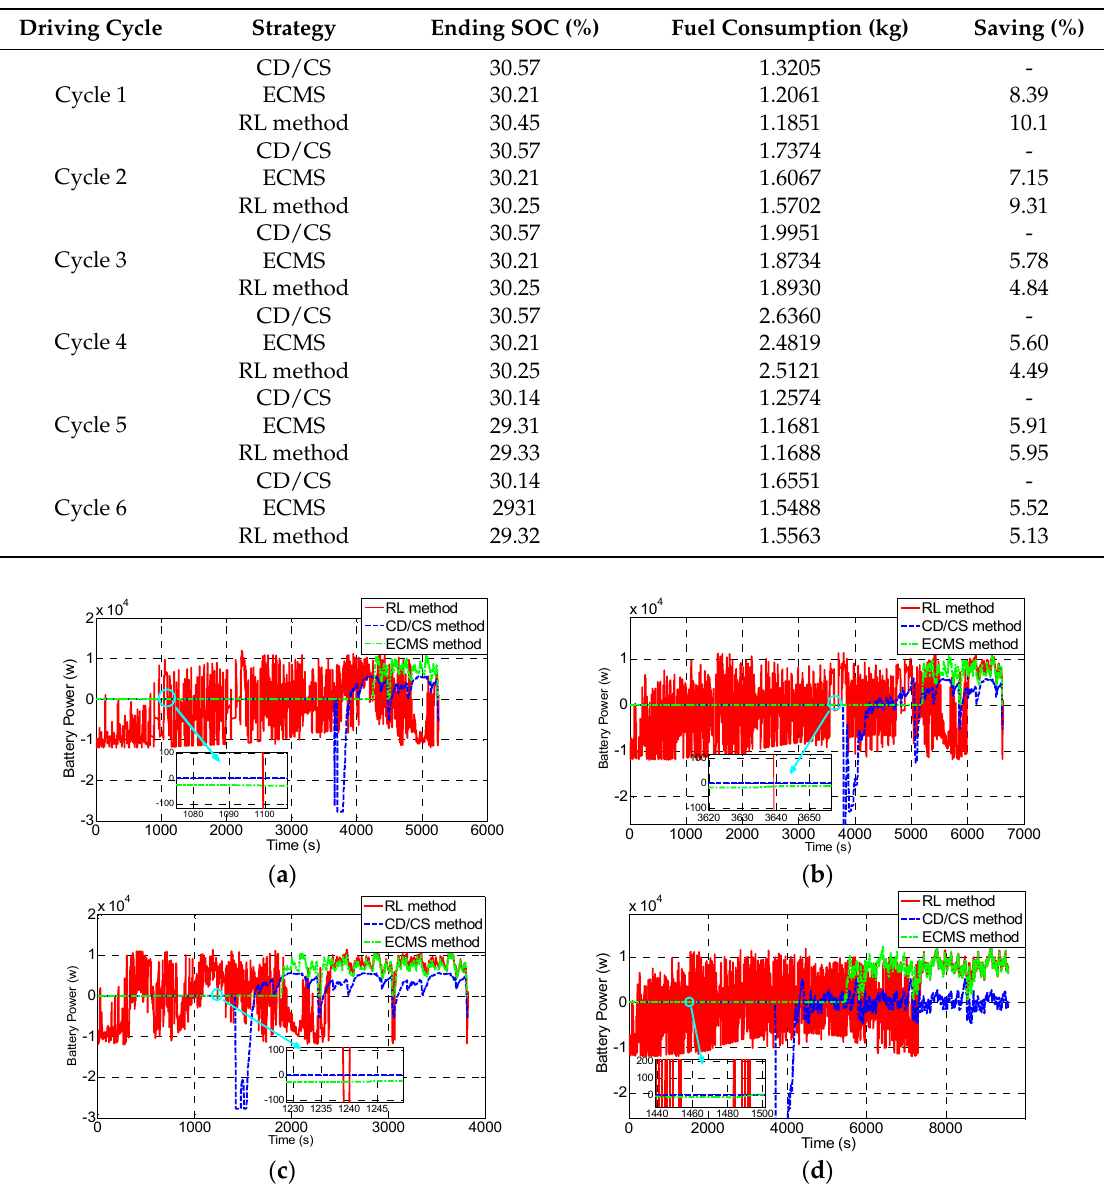
Table 3. Fuel economy comparison.